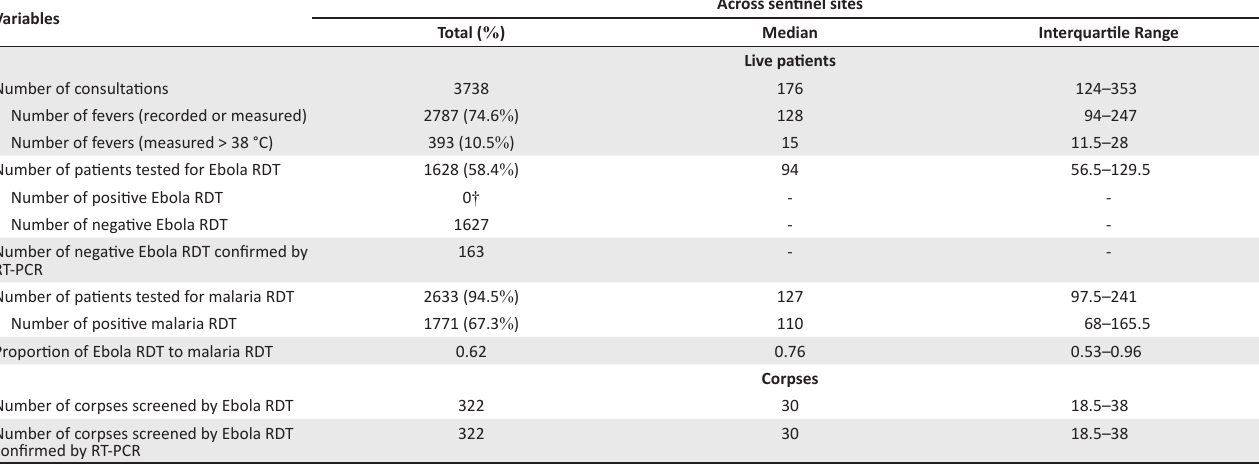
Across sentinel